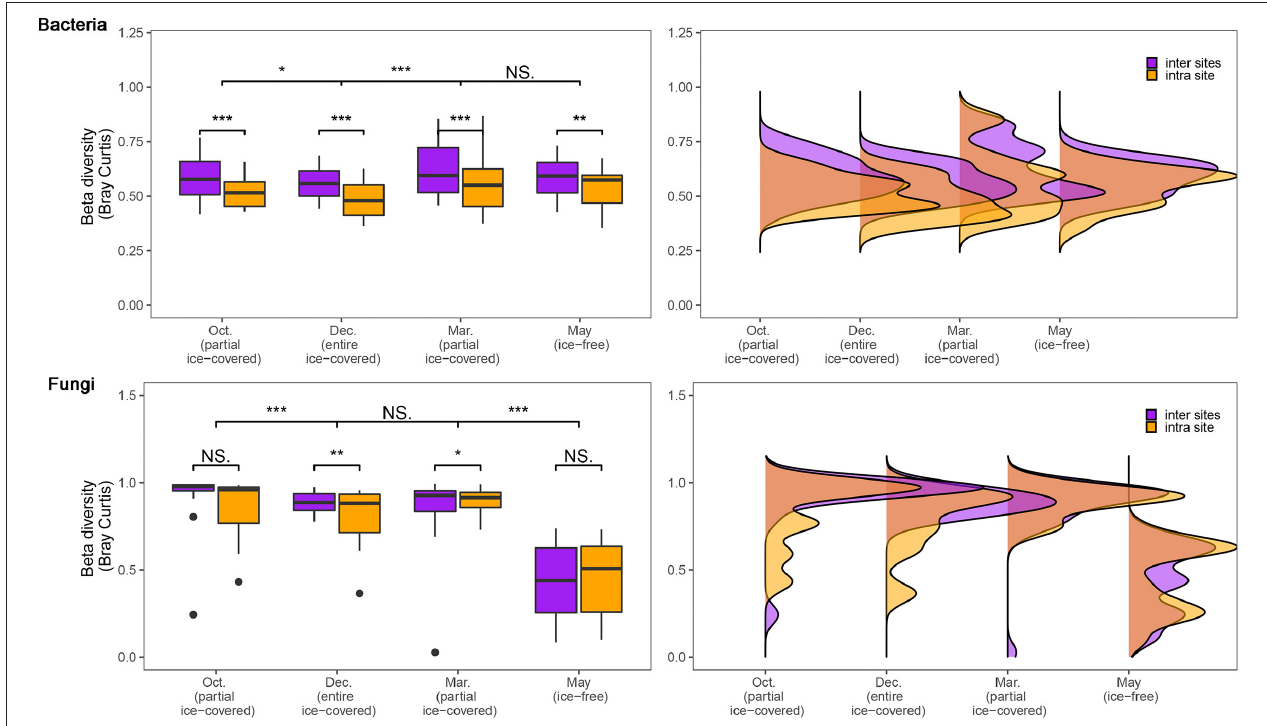
FIGURE 2 | Dissimilarity of bacterial and fungal communities during different ice-covered stages. Community dissimilarity was calculated using the Bray-Curtis distance. To assess the influence of geographical distances, the samples were divided into “inter sites” and “intra site” groups. The “inter site” group includes samples among different sites ( > 3,000m); the “intra site” group includes samples within the same site (range of 30 × 30m). Significance of the Adonis tests: NS., not-significant; * p < 0.05; ** p < 0.01; *** p < 0.001.